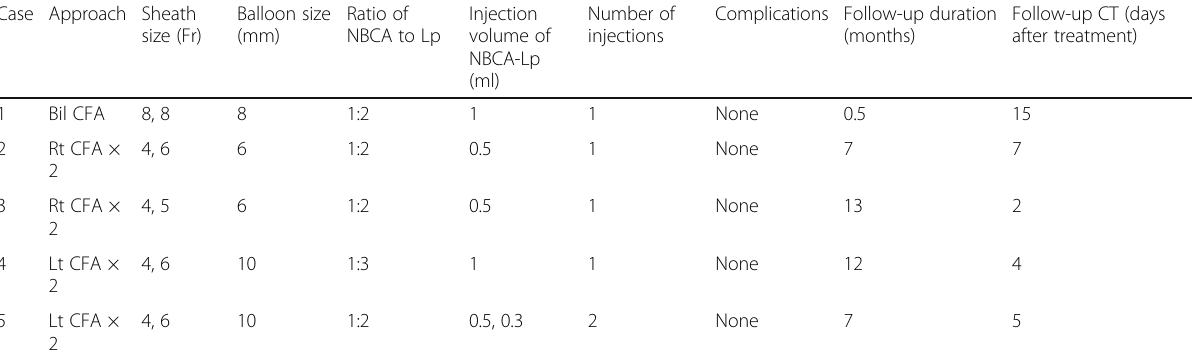
Table 2 Procedure results Case Approach Sheath size